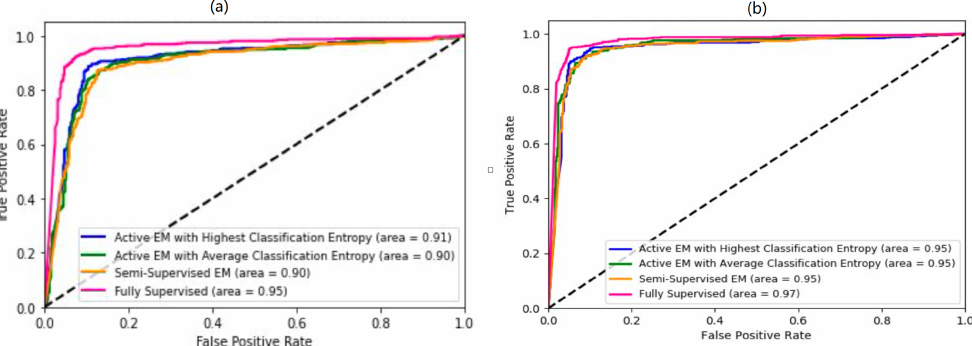
Figure 8. Active phase: 10 labels per iteration for the NLST dataset using a CNN with ( a ) 25% and ( b ) 50% of initial